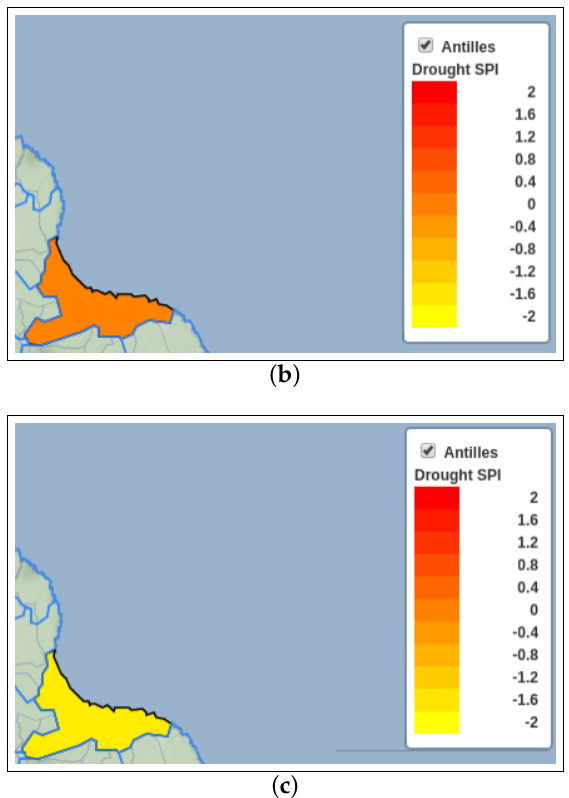
Figure 14. Simulation: how standardized-precipitation-index (SPI)-level projections could be displayed in DKP in ( a ) 2020, ( b ) 2033, and ( c ) 2085.